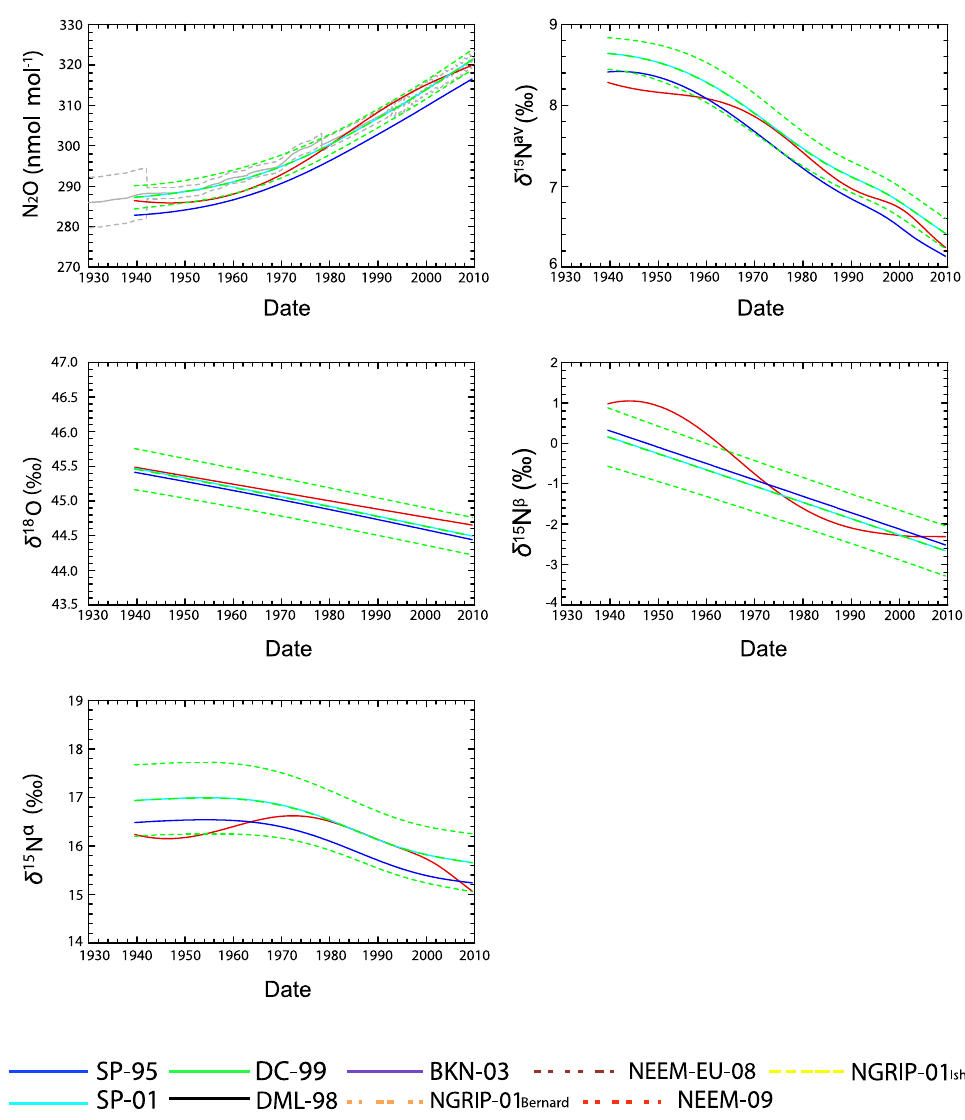
Figure C4. Comparison of the atmospheric reconstructions between different re-scaling methods. Solid and dashed green lines are the scenarios from data re-scaled to DC-99 used in this study. Solid red lines are the best-case scenario for the non-re-scaled data and solid blue lines are the best-case scenarios from the data re-scaled to NEEM-09. The latter data series is shifted because of a calibration offset. When this is corrected for, the data superimpose the green lines, as